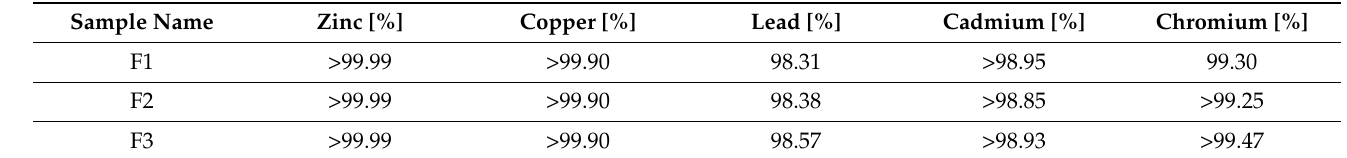
Figure 6. The microstructure of slurry E specimens after 28 ( a ) and 90 ( b ) days of curing; visible C-S-H phase and ettringite. Table 8. Heavy metal